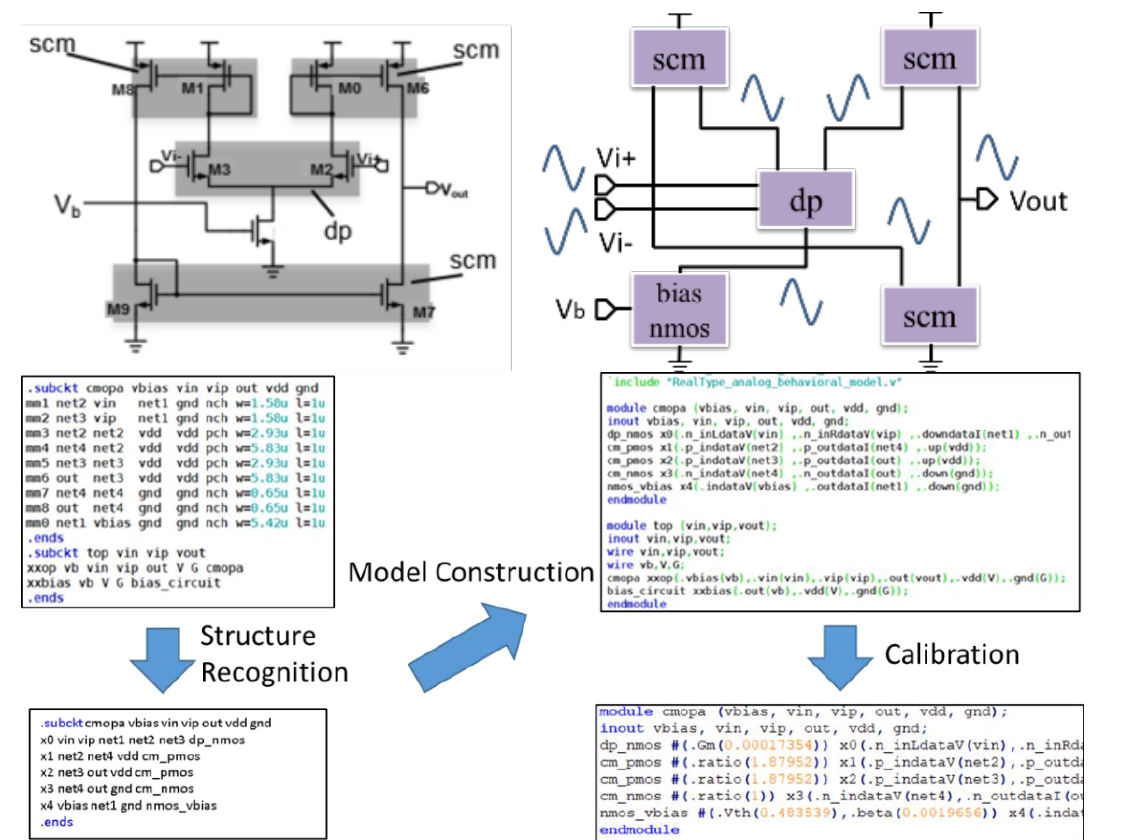
Figure 15. Example of the model construction and calibration process.